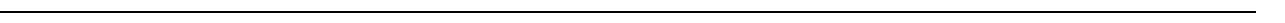
Fig. 3 BAD-LAMP is co-localised with TLR9 and MYD88 upon activation by CpG. a ( left ) Immuno fl uorescence confocal microscopy (ICM) of CAL-1 and freshly isolated pDCs stimulated or not (NS) with CpG-A for indicated times was performed to visualise BAD-LAMP ( green ), MYD88 ( red ) and TLR9 ( cyan ). Arrowheads point at co-localisation area. ( right ) Co-localisation quanti fi cations using Pearson ’ s coef fi cient measurement (ImageJ) are shown for TLR9 and BAD-LAMP ( red line ), MYD88 and TLR9 ( black line ), MYD88 and BAD-LAMP ( dashed line ) during time. Graphics represent Pearson ’ s coef fi cient means of 50 different cells ± s.d. for each time point from at least three independent experiments. b Voxel gating analysis of immuno fl uorescence confocal images of CAL-1 cells presented in a . Voxel gating was performed on TLR9 ( cyan ) and MYD88 ( red ) channels to generate a ‘ coloc channel ’ picture only showing co-localisation areas between the two proteins. This ‘ coloc channel ’ was then merged with single BAD-LAMP staining to obtain simpli fi ed tri- localisation images, revealing strong BAD-LAMP co-localisation with TLR9/MYD88 after 1 h of CpG-A exposure. Scale bars = 5 μ M. c – e Immuno fl uorescence proximity ligation assay (iPLA) on CAL-1 or freshly isolated pDCs stimulated with CpG-A for indicated times performed for BAD-LAMP and UNC93B1 ( c ), BAD-LAMP and TLR9 ( d ), and TLR9 and MYD88 ( e ). ( left ) Confocal images are representative of at least three independent experiments in which the nucleus is stained by DAPI ( blue ) and proximity between the two proteins of interest is revealed by incorporation of labelled nucleotide ( red ) during the ligation reaction. Scale bars = 10 μ M. ( right ) Quanti fi cation of iPLA for pDCs ( black line ) and CAL-1 ( dashed line ) by counting the number of red dots normalised to nucleus numbers using imageJ. Graphics are representing means of dots/cell for 150 different cells ± s.d. from at least three independent experiments. The bimodal regulation of TLR9 signalling is represented with a shading red rectangle for its IRF7-dependent phase and blue for its NF- κ B-dependent